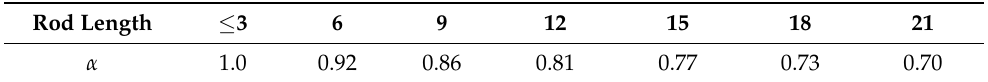
Table 4. Correction coefficient of rod